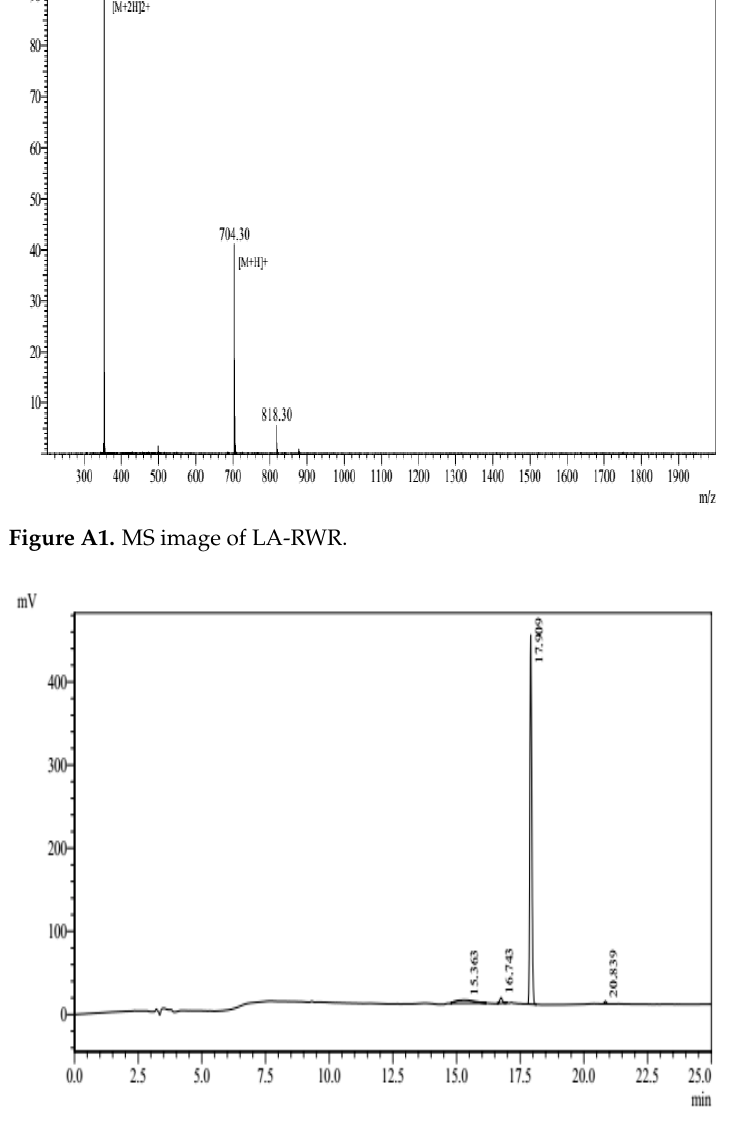
Figure A3. MS image of LA ‐ RWR ‐ PEA.